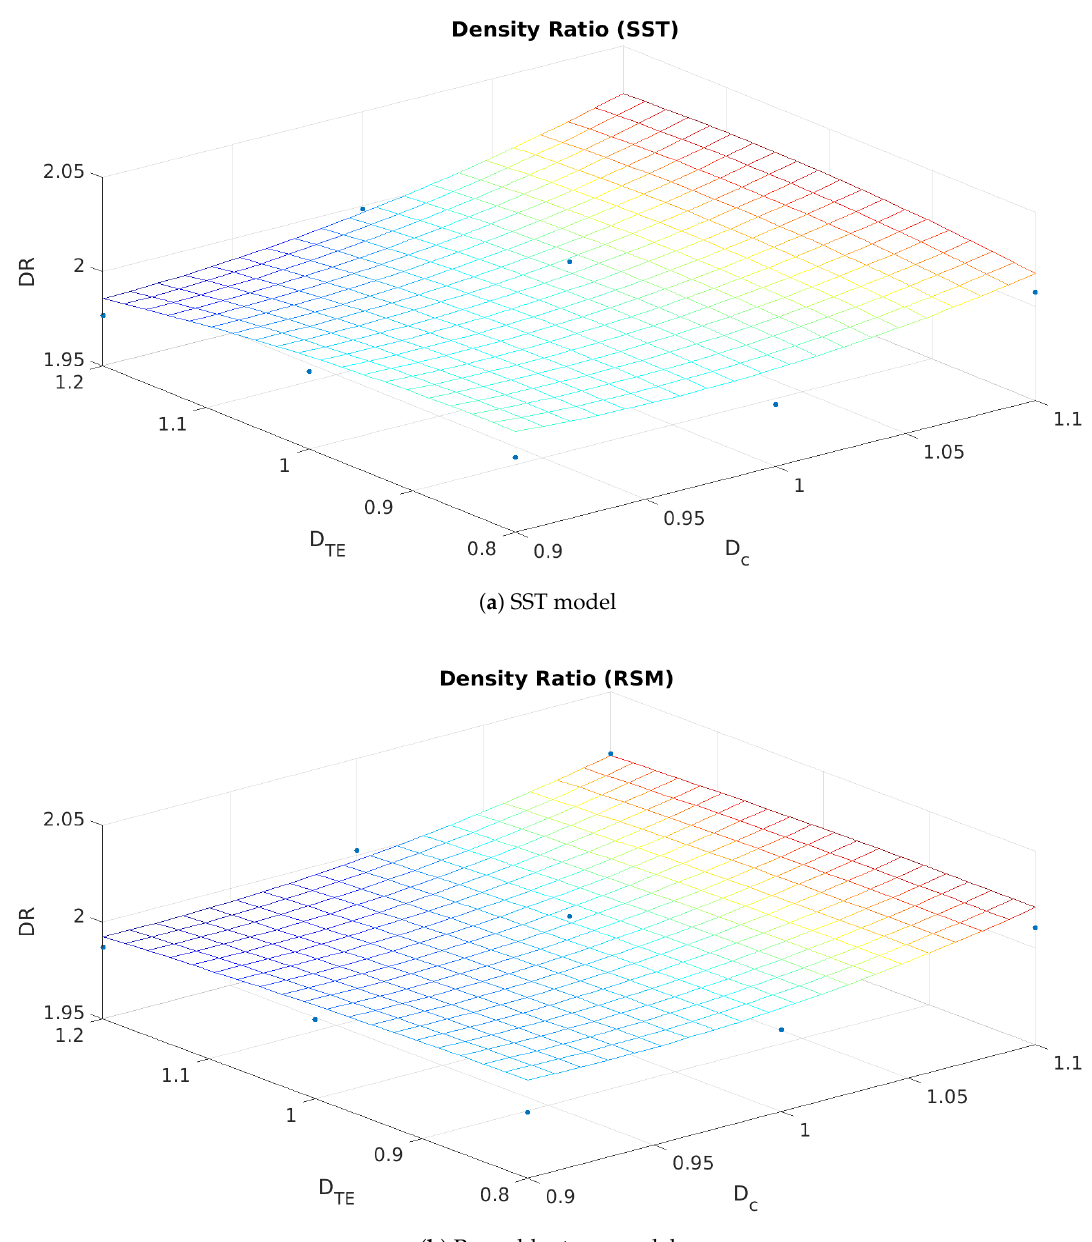
Figure 10. Density Ratio DR (Hermite